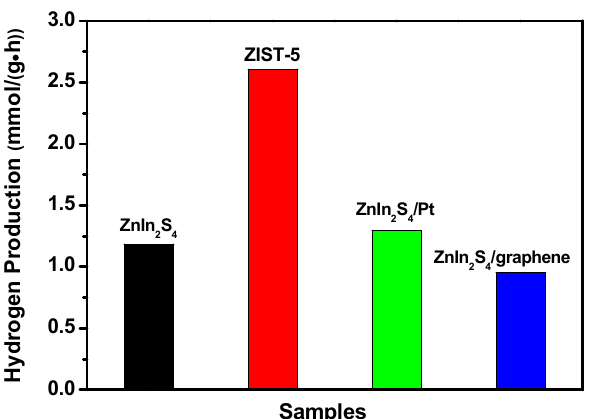
Figure 13. ( a ) Cycling tests of photocatalytic H 2 production under visible light irradiation over ZIST-5. ( b ) XRD patterns for experimental ZIST-5 before and after the reaction.